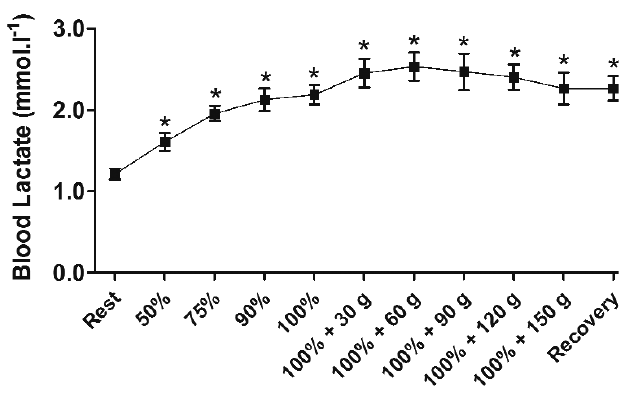
Figure 1. All values are presented as means ± standard error of the mean. Blood lactate concentrations during acute exercise tests are shown for resting conditions (Rest n=20), after climbs carrying 50% (n=30), 75% (n=30), 90% (n=30), 100% (n=30), 100% +30g (n=30), 100%+60g (n=30), 100%+90g (n=24), 100%+120g (n=20), 100%+150g (n=13) of the pre-determined maximum carrying capacity, and following recovery (Recovery n=30). * different from Rest; P <